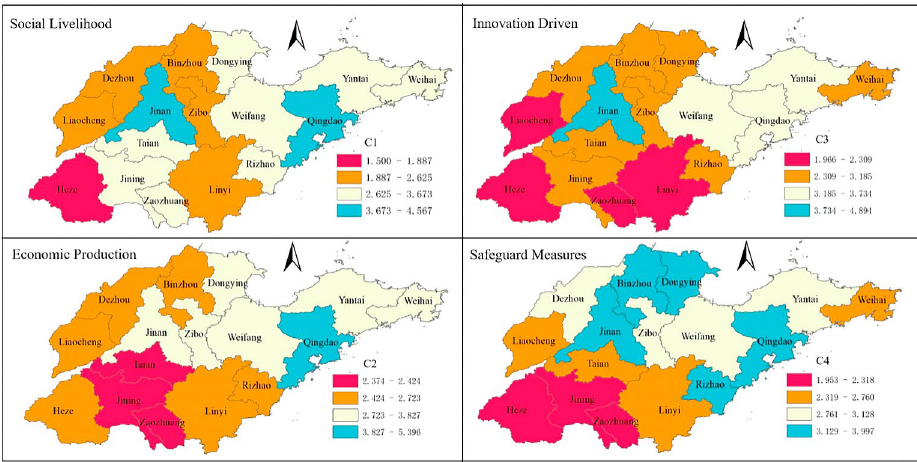
Figure 2. Construction level indicators of new SCCs in Shandong Province by